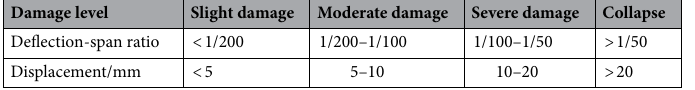
Table 4. Damage criteria for different levels.